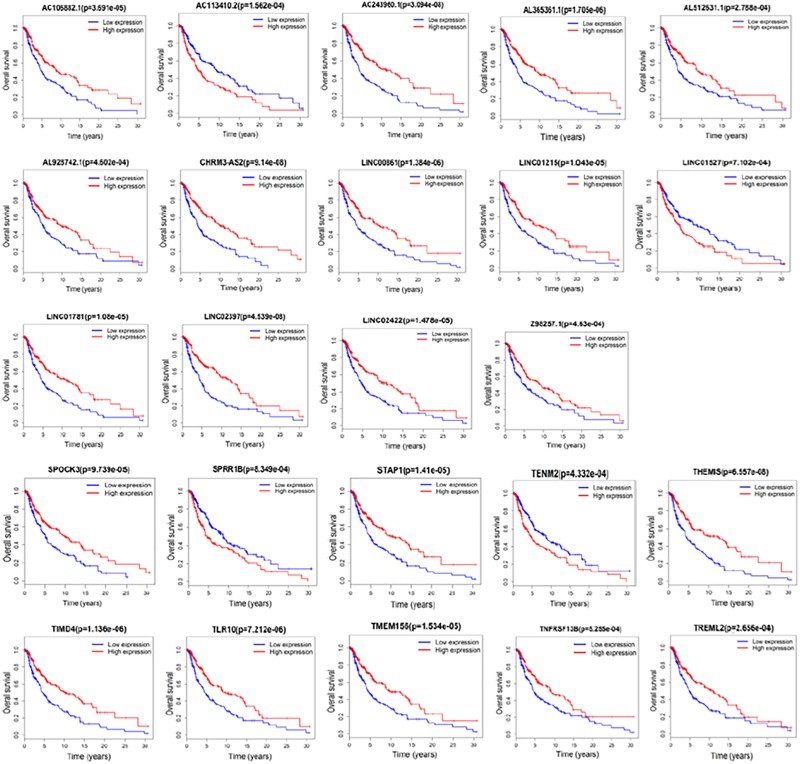
Kaplan–Meier analysis for overall survival rate of patients from TCGA. Log-rank test was performed to evaluate the survival differences between the two curves (p < 0.001). Overall survival rate for 14 lncRNAs and 10 mRNAs were identified significant.